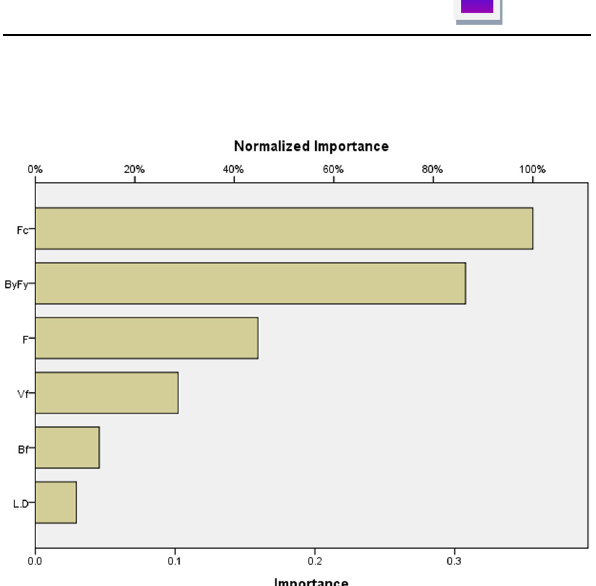
Figure 4: Normalized importance of recent ANN Model ( from SPSSV.19 software ) .